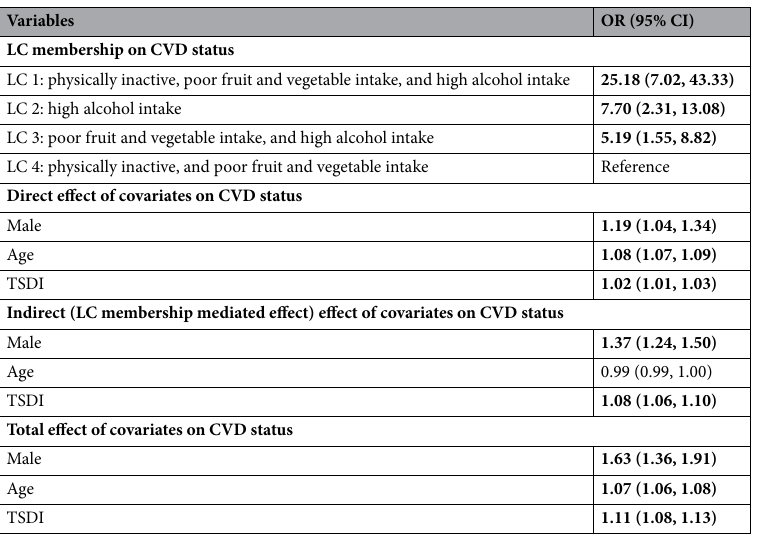
Table 4. Latent class membership and other factors associated with CVD: multivariable analyses (odds ratios and 95% confidence intervals). Significant values are in